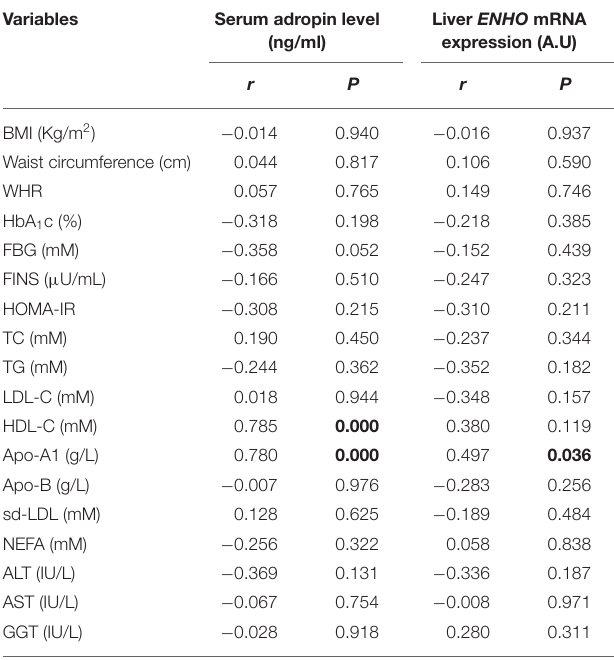
TABLE 3 | Correlation of serum adropin level and liver ENHO mRNA expression with metabolic indicators in MAFLD patients. Variables Serum adropin level Liver ENHO mRNA (ng/ml) expression